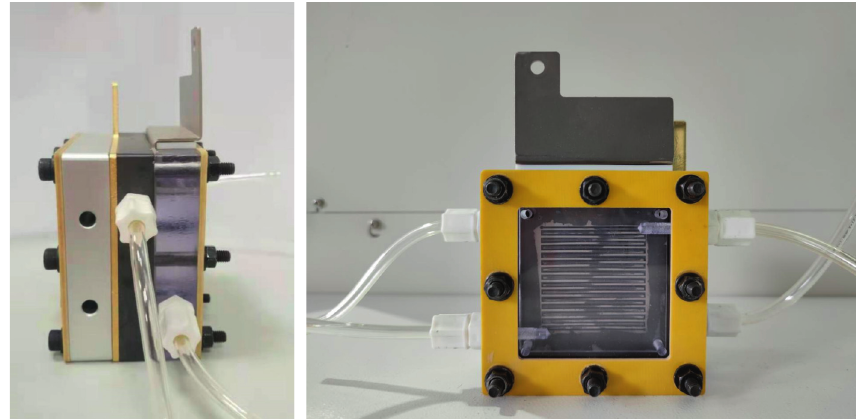
Figure 1: Structure of the cathode visual single fuel cell.